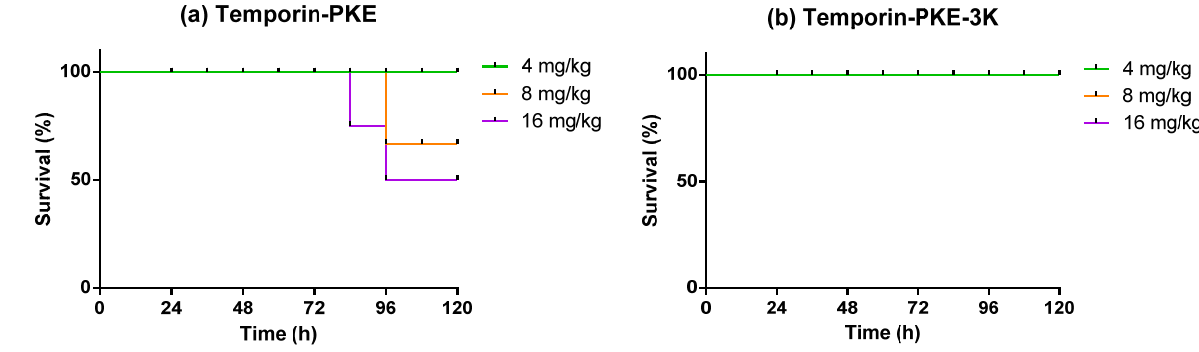
Figure 13. The curves of the survival rate of the waxworm larvae treated with ( a ) temporin-PKE and ( b ) temporin-PKE-3K.